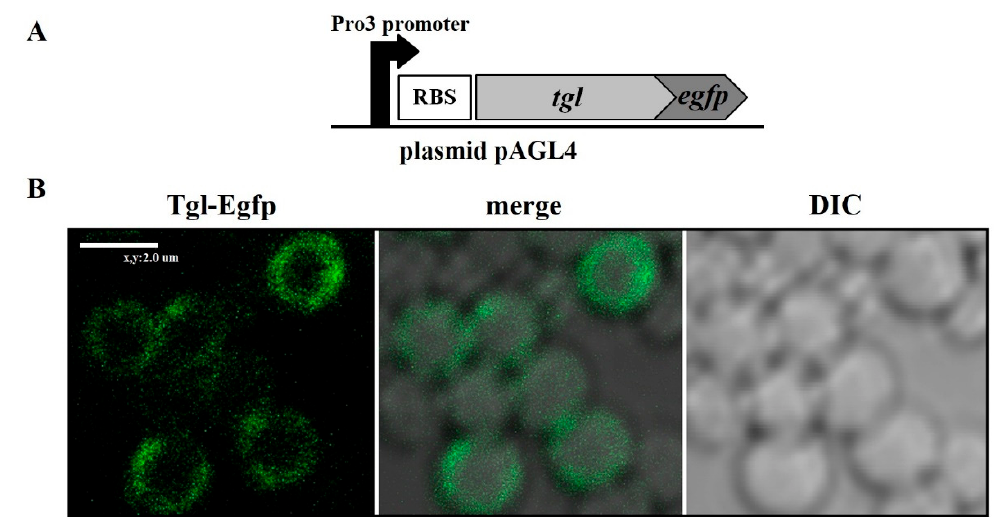
Figure 2. Localization of Tgl–Egfp protein in S. aureus cells. ( A ) Schematic picture of tgl - egfp expression cassette in pAGL4 plasmid. ( B ) Confocal microscope images (left panel) and differential interference contrast (DIC) images (right panel) of S. aureus cells producing Tgl-Egfp protein. Central panel shows the merging of both images.